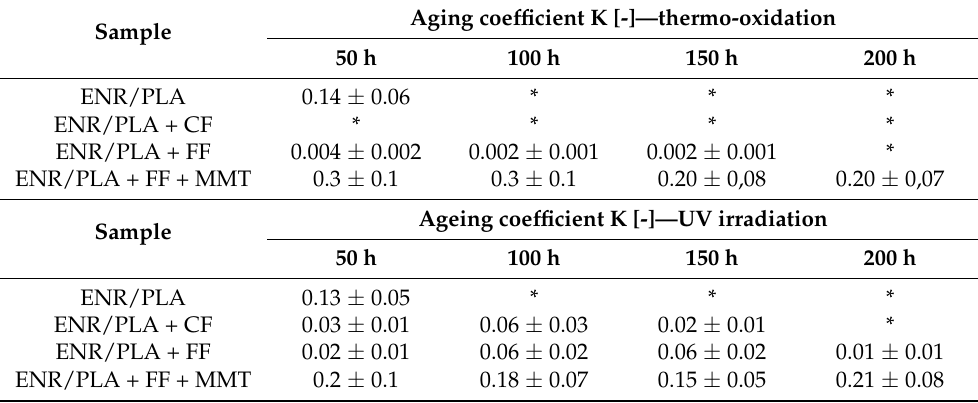
Table 4. Aging coefficients attributed to the filled and unfilled ENR/PLA specimens at a certain aging time. * sample too brittle to be examined with the selected method; the measurement was impossible.